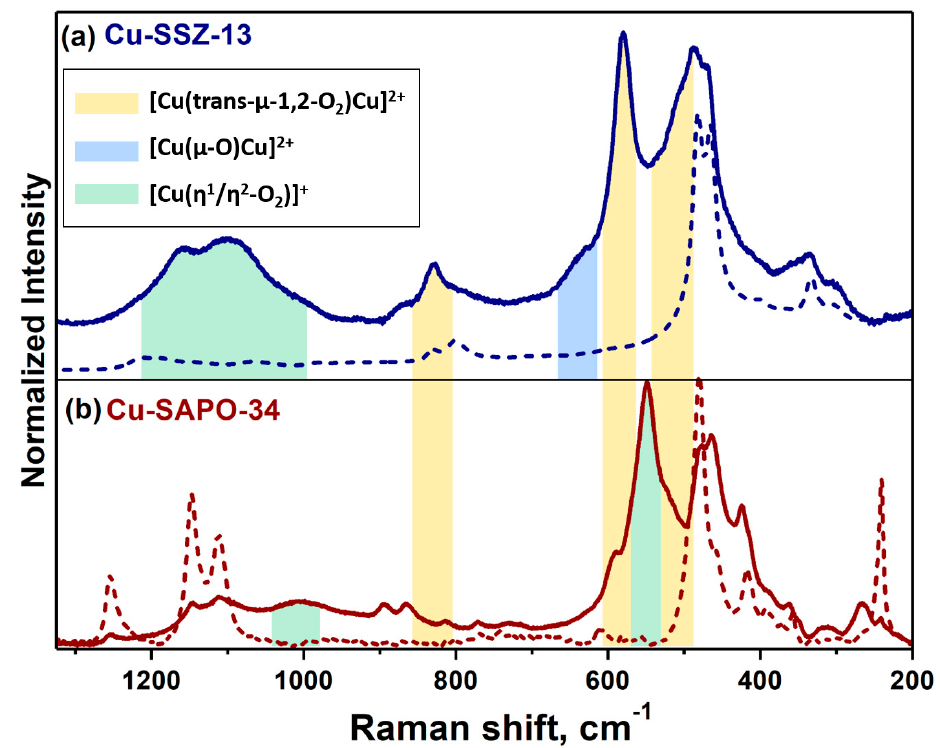
Figure 4. Raman spectra of ( a ) hydrated (dashed blue) and activated (solid blue) 0.50CuSSZ-13, and ( b ) hydrated (dashed red) and activated (solid red) 0.25CuSAPO-34. The contributions from different Cu(II) x O y moieties are marked. Yellow shading: [Cu(trans- µ -1,2-O 2 )Cu] 2 + , blue shading: [Cu-( µ -O)-Cu] 2 + and green shading: [Cu( η 1 / η 2 -O 2 )] + .